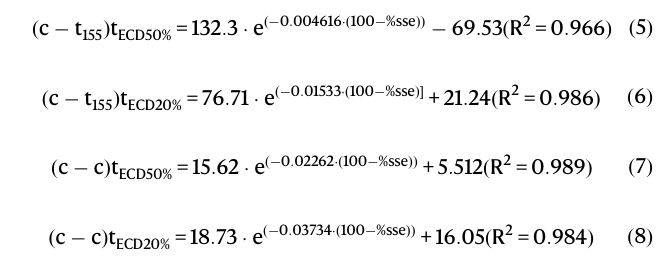
WhereYisthetimeneededtoreducetheECDsignaltothe50%or20%.